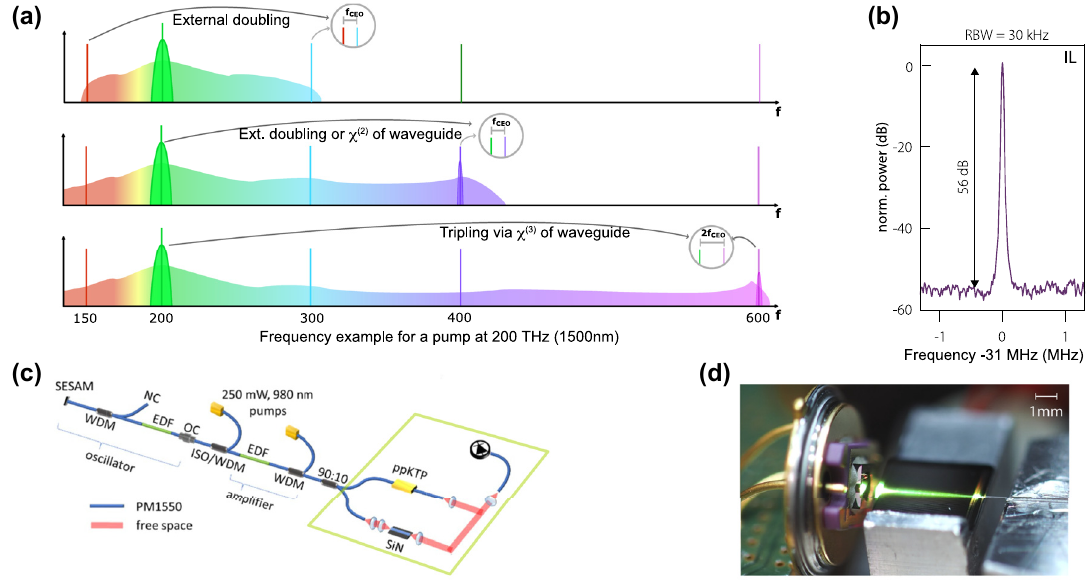
Figure 17: Nanophotonic waveguides for self-referencing applications. (a) A sketch showing different schemes to self-reference a mode-locked laser (for illustration purposes here centered at 200 THz) using SC and nonlinear multiplication. The top scheme is the one usually used when generating the SC in a fiber. The bottom two are mostly used in waveguides due to the very high efficiency of the SCG and the ability to efficiently double the beatnote with a very high SNR detected right after an LNOI waveguide for a pump at around 1560 nm. (c) The full setup of pump. (b) Example of a f CEO a self-referenced fiber laser, here using a silicon nitride waveguide and external doubling in a periodically-poled KTP crystal (ppKTP). The components required for self-referencing are marked with a green box. (d) Thanks to the intrinsic 𝜒 (2) nonlinearity of LN, all components of the green box can be integrated into a volume of around 1 cm 3 . This configuration was used to generate the signal of (b). Both (c) and (d) use the center scheme of (a) in the two indicated variations for the doubling. Panels (b) and (d) adapted from [62], panel (c) adapted from